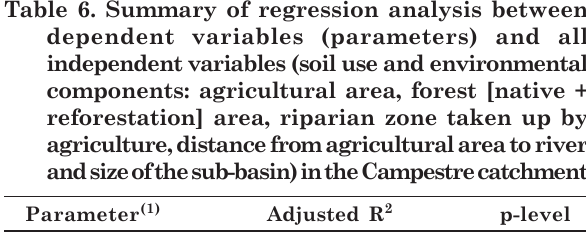
(1) Analysis performed taking the average of the monitoring sites A1, A2 and A3 for sub-basin A; and B1, B2, B3 and B4 for sub- basin B; (2) Analysis performed on material from the outlet monitoring site of the sub-basin (A3 × B4). *: statistically different; ns: not statistically different. Table 6. Summary of regression analysis between